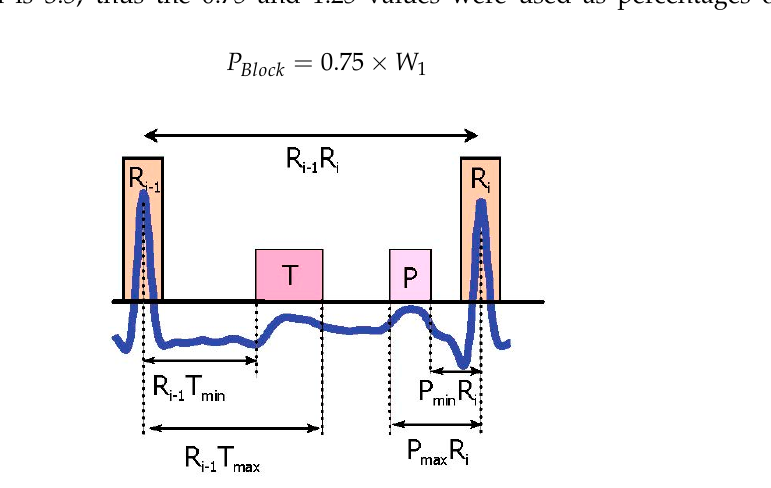
Figure 4. P and T wave time occurrence with respect to the current R peak and next the R peak . The R i − 1 T min represents the minimum interval between the T wave and current the R peak, while R i − 1 T max is the maximum interval between the T wave and the current the R peak. Here, P min R i represents the minimum interval between the P wave and next the R peak, and P max R i stands for the maximum interval between the P wave and next the R peak.